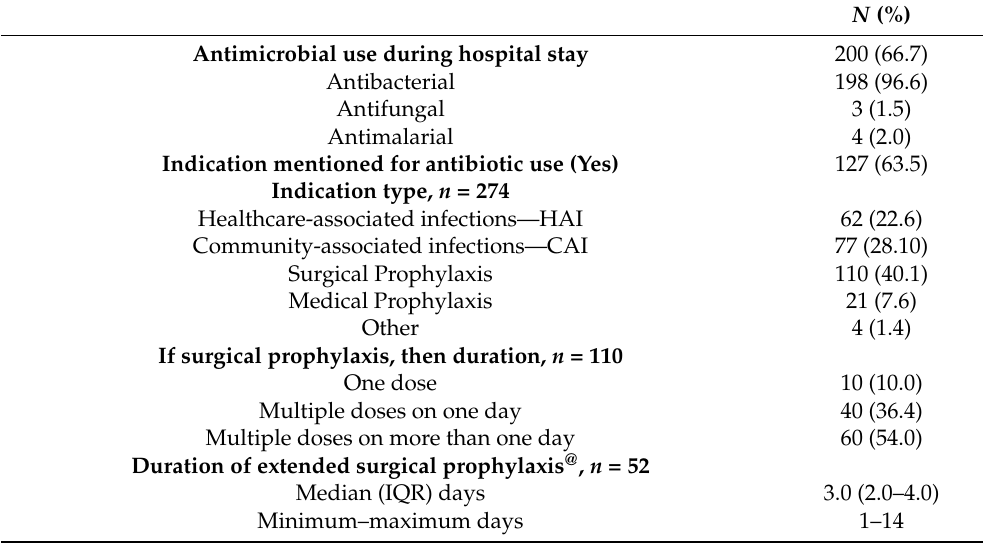
Table 2. Use and pattern of antimicrobial